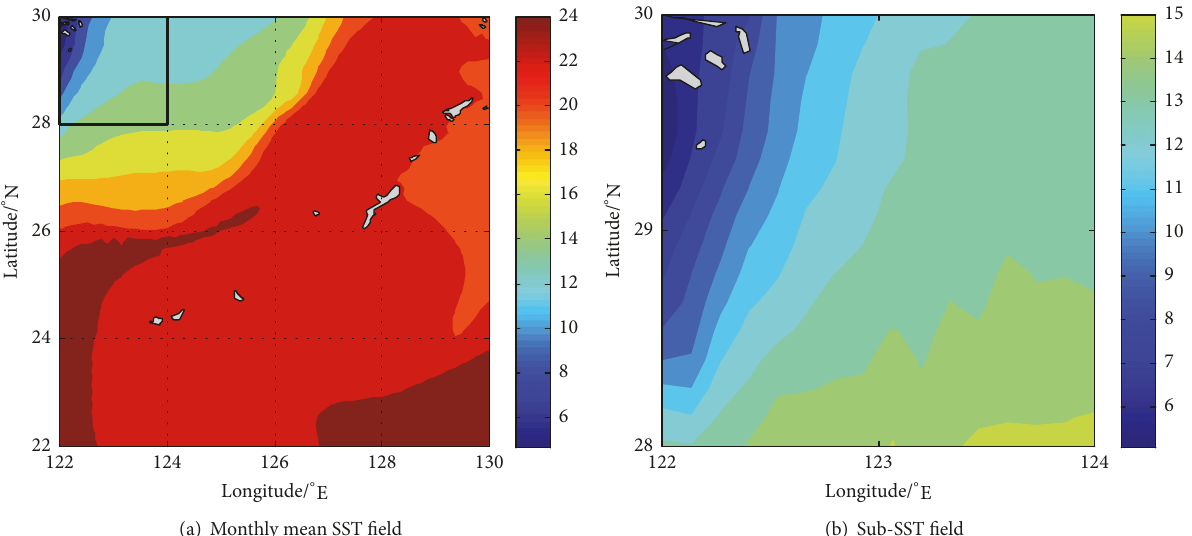
Figure 2: The monthly mean SST field in February 2009 in the East China Sea.